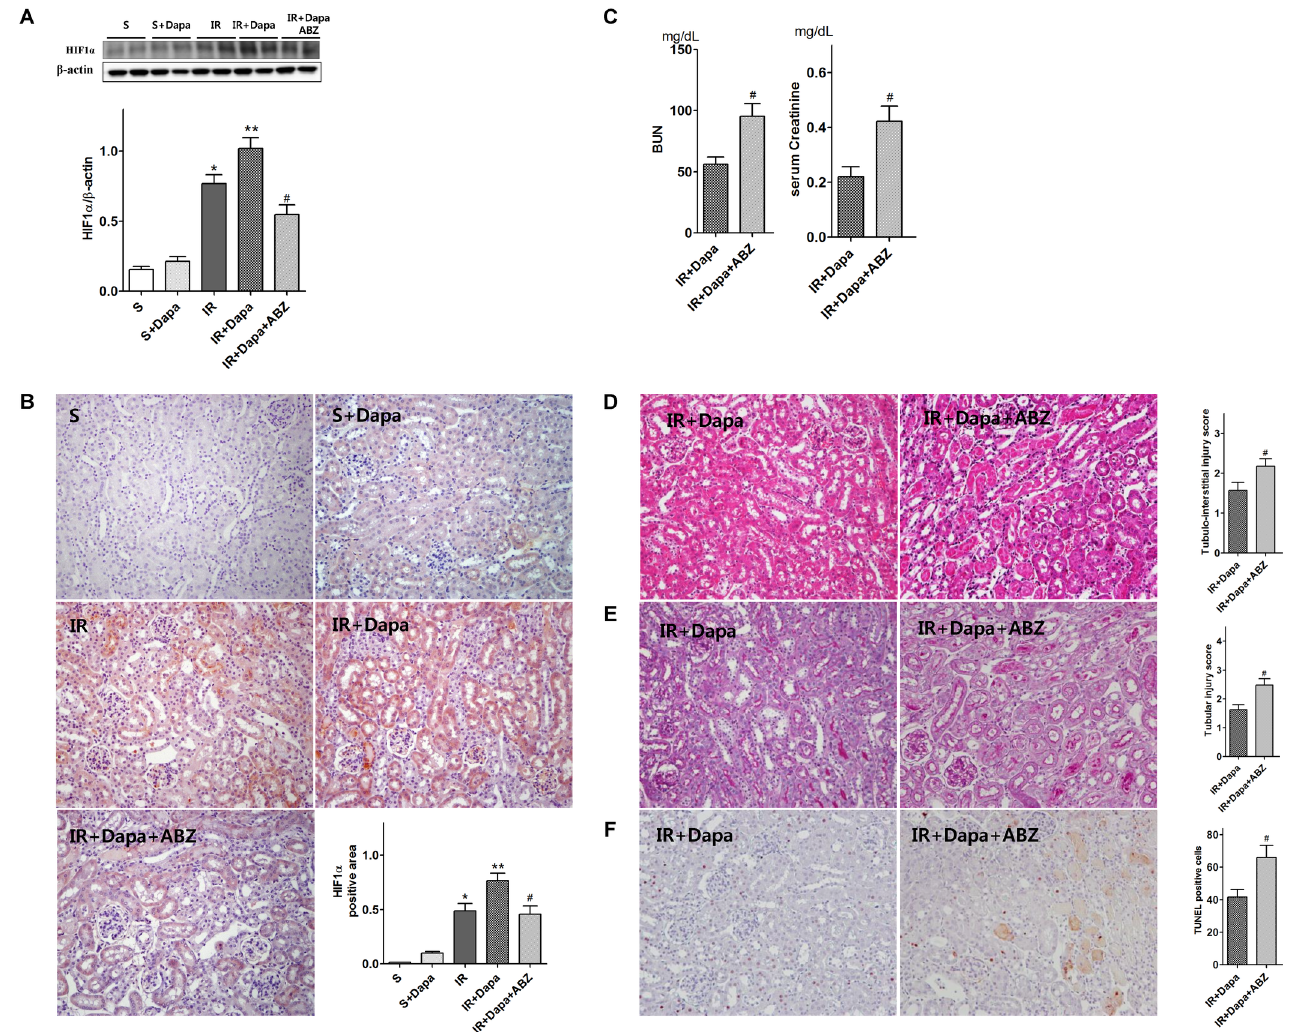
Fig 6. Effects of dapagliflozin on HIF1 in IR-injured kidneys (S (n = 5), sham; S+Dapa (n = 5), sham+dapagliflozin; IR (n = 7); vehicle-treated renal IR mice; IR+Dapa (n = 7), dapagliflozin-treated IR mice; IR+Dapa+ABZ (n = 7), albendazole- and dapagliflozin-treated IR mice). (A) Representative Western blot: dapagliflozin increased HIF1 expression in IR-injured kidneys. Albendazole decreased HIF1 expression in dapagliflozin-treated IR-injured kidney. (B) Representative Immunohistochemistry of HIF1. Dapagliflozin increase the HIF1 stained area in tubular area of IR kidney. Original magnification, 200× (C) The effects of dapagliflozin on renal function. Albendazole treatment elevated BUN and serum creatinine in dapagliflozin-treated IR mice. (D – F) Representative kidney section: albendazole treatment increase tubulointerstitial injury and TUNEL-positive cells in IR-injured kidneys. * P < 0.05 vs. vehicle-treated sham, ** P < 0.05 vs. vehicle-treated IR, # P < 0.05 vs. dapagliflozin-treated IR. Bar represents mean ±